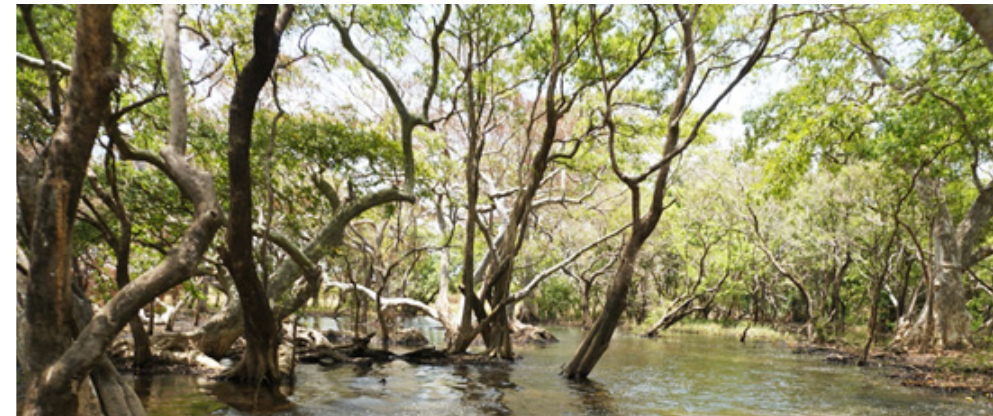
Figure 1: Remains of an ancient irrigation tank functional during the Polonnaruwa Period, is presently sand-filled and retains only up to one meter- deep water; this wetland habitat is colonized by a grove of Terminalia arjuna (“Kumbuk’) trees, mimicking a river forest.